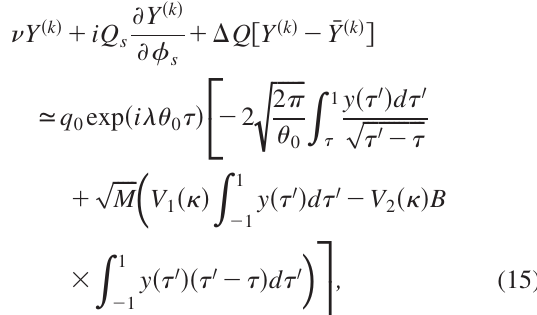
ffiffiffiffiffiffiffiffiffiffiffiffiffiffiffi p 1 (cid:1) A 2